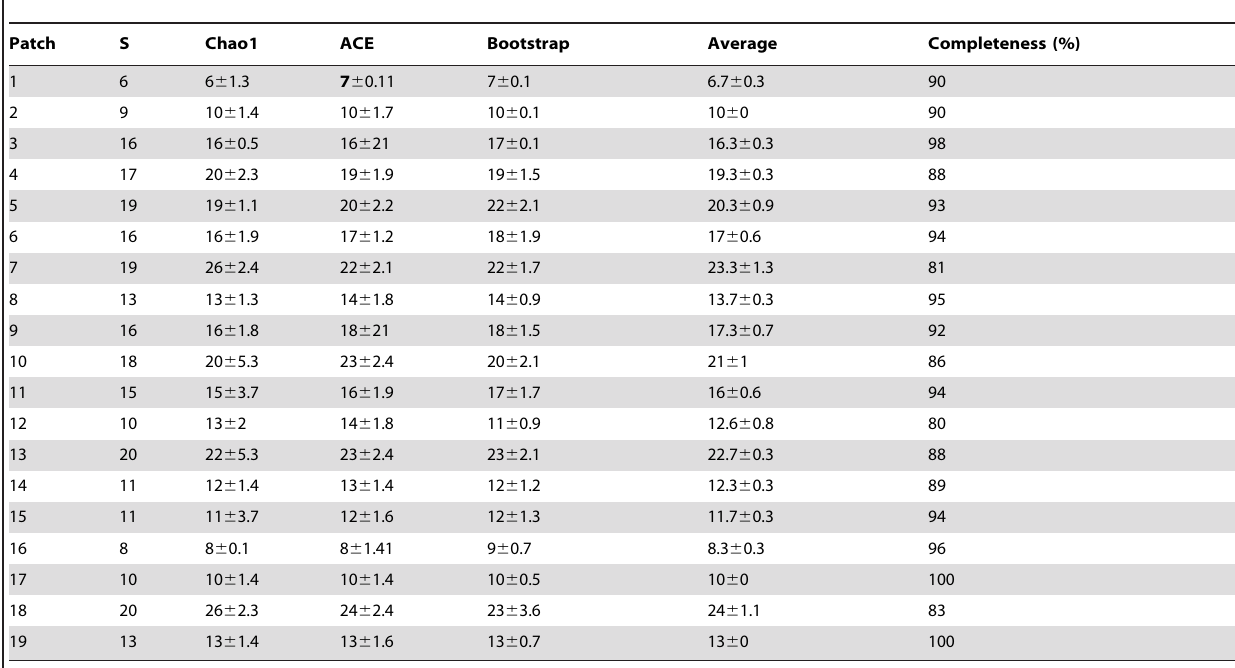
Table 1. Number of species observed in 0.1 ha samples (S) and predicted number of plant species using three nonparametric estimators (Chao1, ACE and Bootstrap) for 19 forest patches on the Yucatan Peninsula.